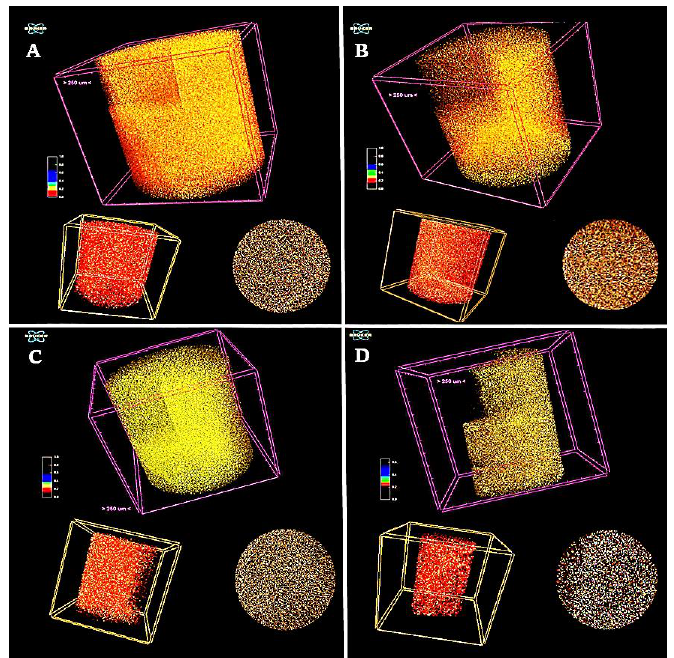
Figure 12. Micro-CT images (250 µ m voxel size) of composite formulations: ( A ) ECP_A5; ( B ) ECP_B5; ( C ) ECP_C5; ( D ) ECP_D5.